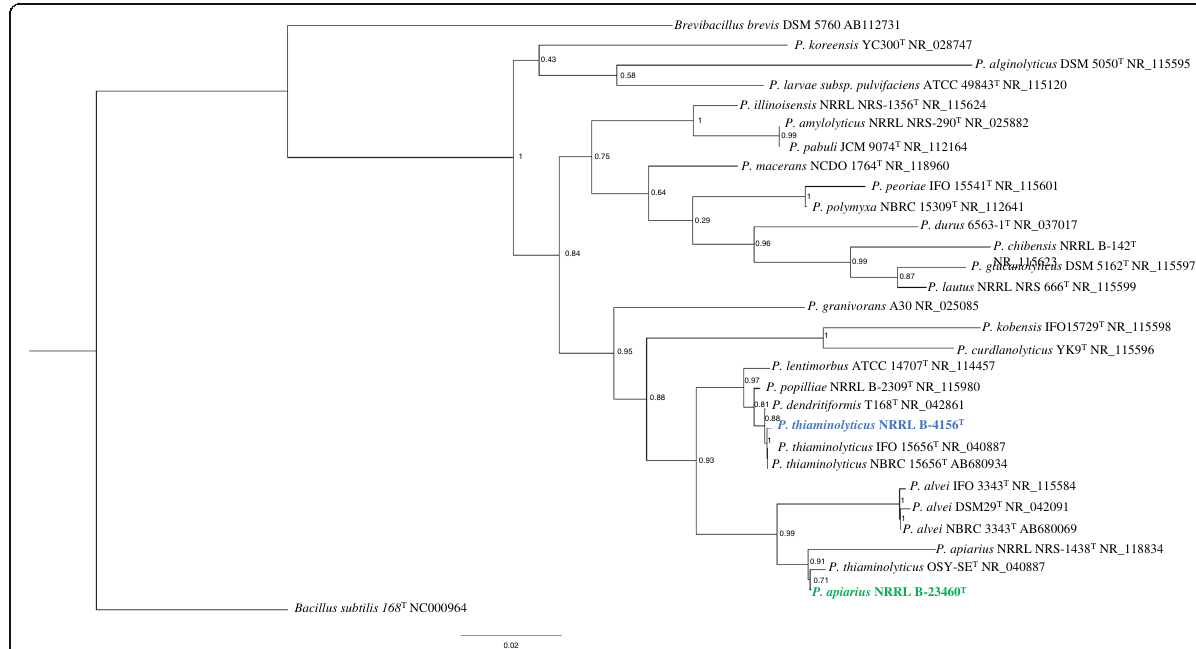
Fig. 2 Phylogenetic tree of Paenibacillus spp. based on 16S rRNA gene sequences. The maximum likelihood tree was inferred from a comparison of sequences from Paenibacillus spp., Brevibacillus brevis DSM 5760, and Bacillus subtilis 168 using FastTree 2.1 [31]. The sequences generated from the draft genomes of this study are highlighted, with Paenibacillus thiaminolyticus NRRL B-4156 in blue font, and P. apiarius NRRL B-23460 in green